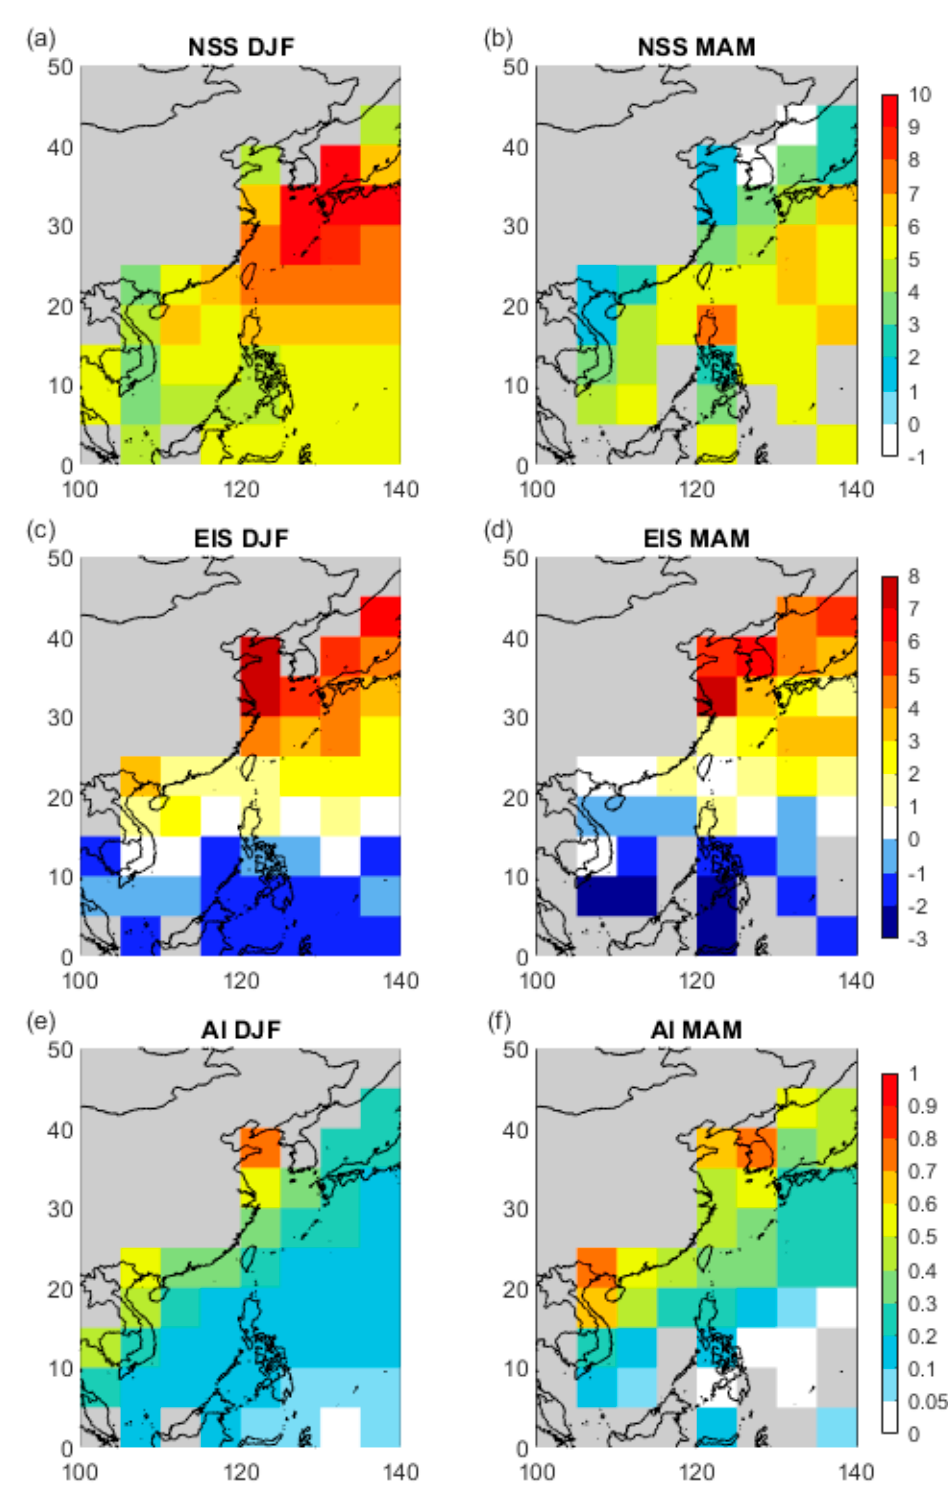
Figure 5. ( a , b ) The 2006–2010 DJF and MAM mean NSS (unit: K), respectively. ( c , d ) The 2006–2010 DJF and MAM mean EIS (unit: K), respectively. ( e , f ) The 2006–2010 DJF and MAM mean AI, respectively. NSS and EIS are derived from ECMWF-AUX. All the filled grids are averaged over the 5° × 5° grid, which contains more than 100 pixels.